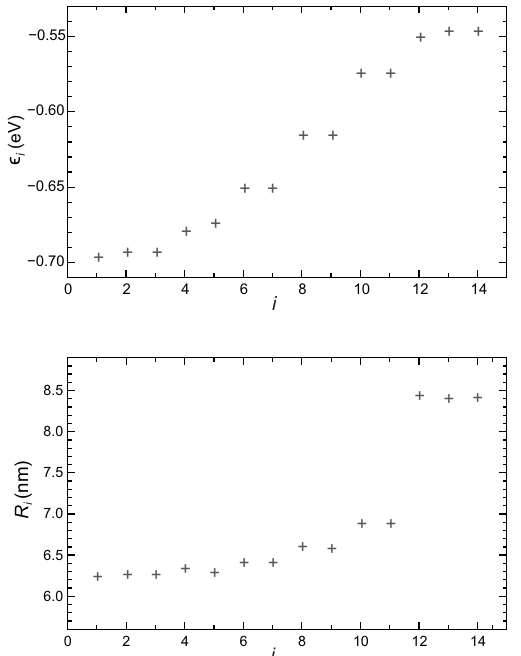
Figure 2. Top : First 14 eigenenergies (cid:101) i of the array with R = 4 nm and a = 30 nm vs. the solution number, i . The bias voltage is V B = 1 V. Notice the parabolic dependence of the energies on i and the degeneracy of numerous eigenstates. Bottom : Average radii R i of the electron-charge distribution in the same eigenstates, also vs. i . Two groups of eigenstates are revealed with notably different radii, R i ≈ 6.5 nm and R i ≈ 8.5 nm, respectively. These groups correspond to the electron shells in atomic physics and are characterized by different numbers of wave-function radial nodes and antinodes.